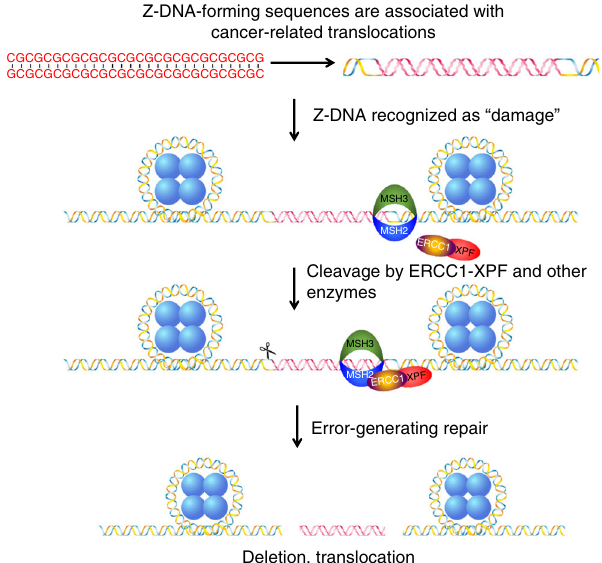
Fig. 5 Proposed mechanism for Z-DNA-induced genetic instability in eukaryotes. During DNA metabolic processes, the CG repeat sequence is unwrapped from histones (blue circles) and negative supercoiling is generated, which stimulates Z-DNA formation. The structure of Z-DNA is recognized as “ damage ” by the MSH2-MSH3 complex, signaling repair. The ERCC1-XPF complex is recruited to the site for cleavage near the Z-DNA- forming region (processing of the B-Z junction on the right side of Z-DNA is shown in the fi gure; however, similar processing could also occur at the other B-Z junction on the left, marked as a scissor), resulting in DSBs in an attempt to repair the “ damage ” . The breaks may be processed in an error- free fashion, or the breaks may be processed in an error-generating fashion resulting in genomic instability in the form of large deletions and translocations, which may contribute to disease